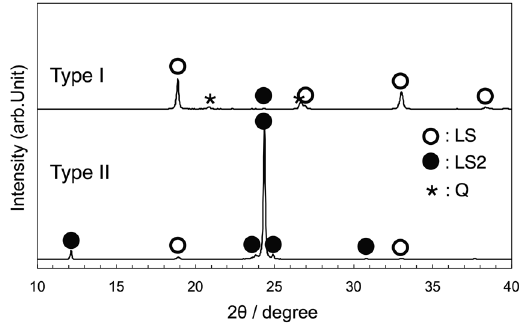
Figure 2. X-ray diffraction patterns of cooled samples under Ar, with Type Ι crystallization, and dry–air, with Type ΙΙ crystallization.